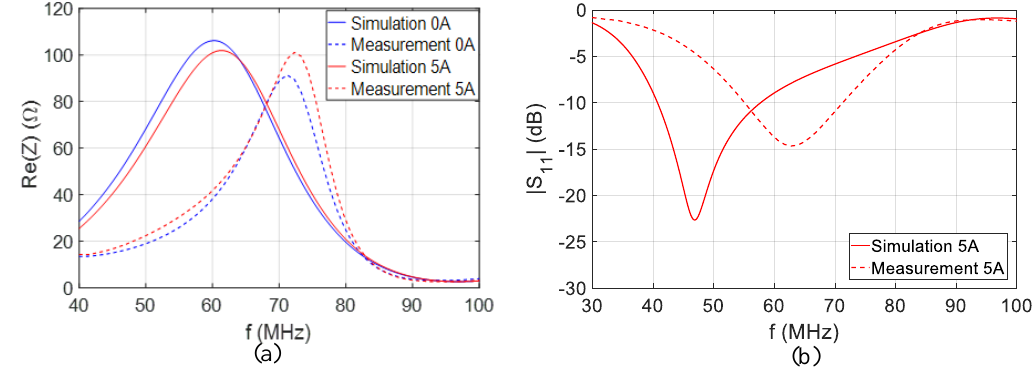
Figure 11. ( a ) Real part of impedance measurement and simulation comparison in the same biasing condition, and ( b ) simulated and measured antenna operation frequencies with 5 A bias current.